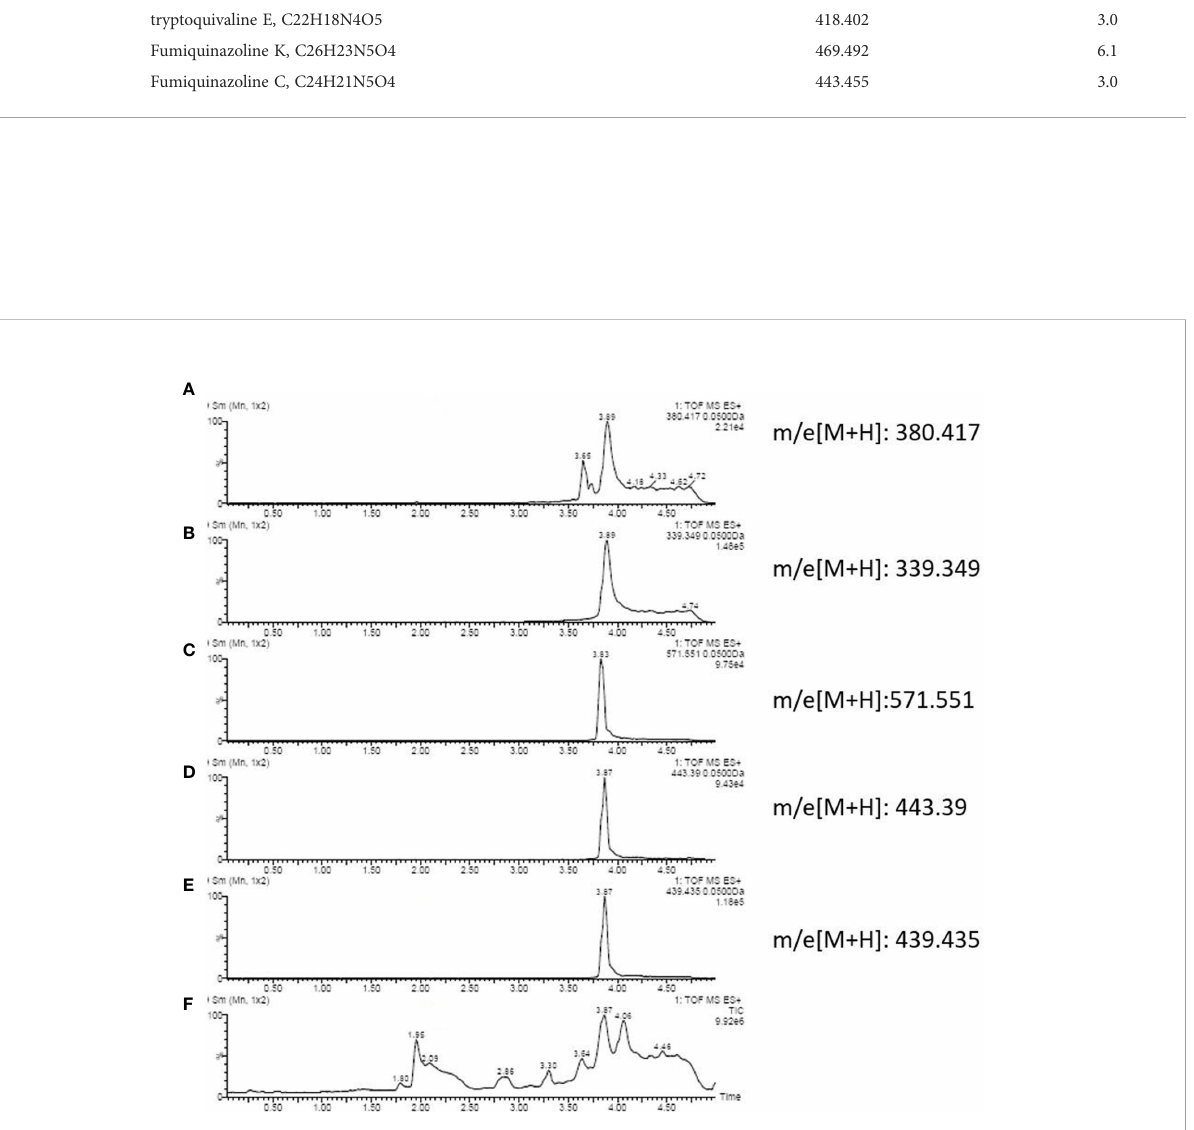
FIGURE 2 Ion chromatography of an EBC sample that consists of: (A) Cyclotryprostatin D; (B) Terphenyllin; (C) Asperpyrone C; (D) Terrelumamide B; (E) Kotanin; and (F) total